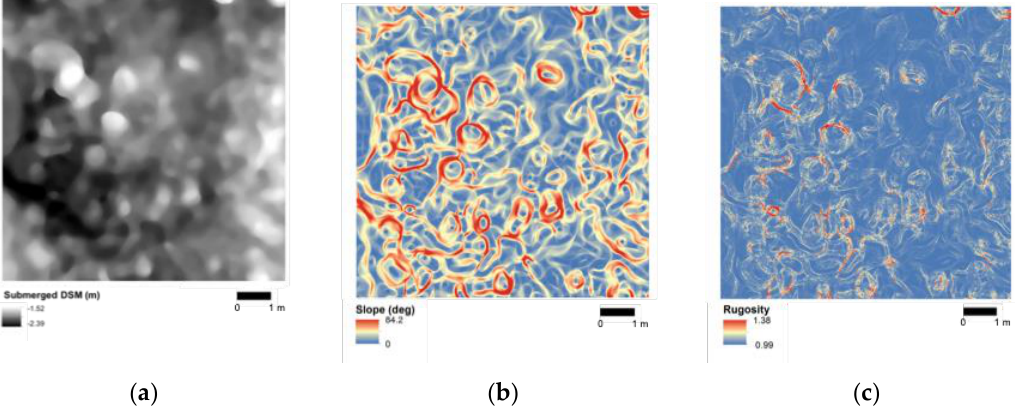
Figure 9. From the UAV based SfM-MVS products at the Jatobá site: ( a ) Submerged DSM with refractive index correction applied, ( b ) Slope, ( c ) Rugosity expressed as the surface to planar ratio. From the underwater SfM-MVS a higher GSD (1 mm) was achieved allowing for a more precise